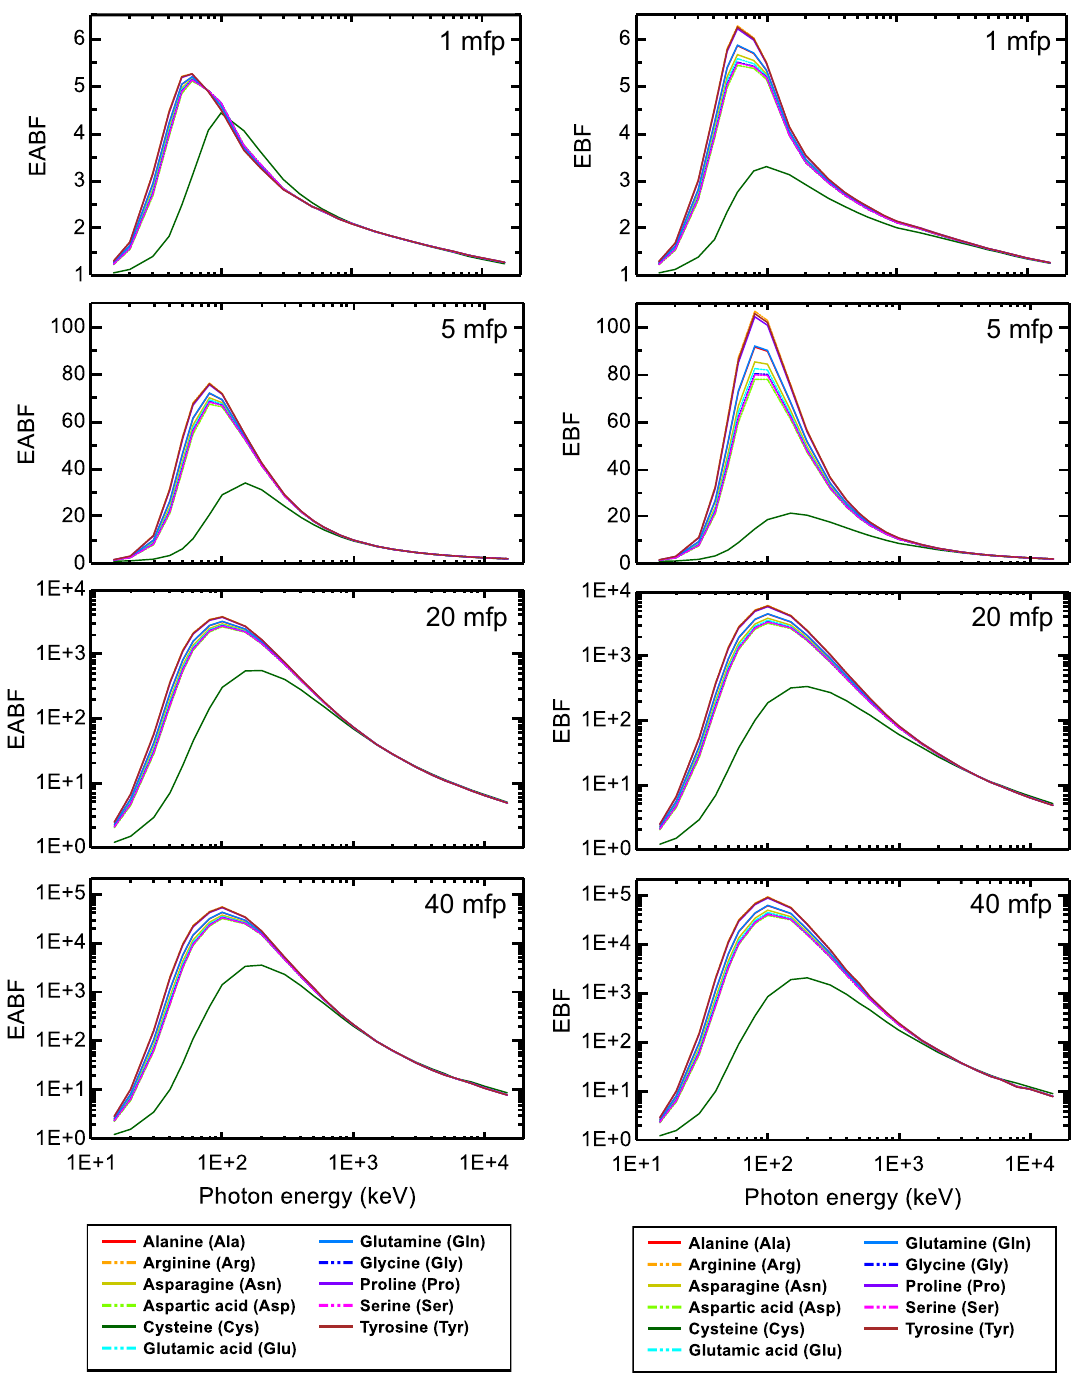
Fig. 4 The buildup factors (EABF and EBF) for NEAAs using